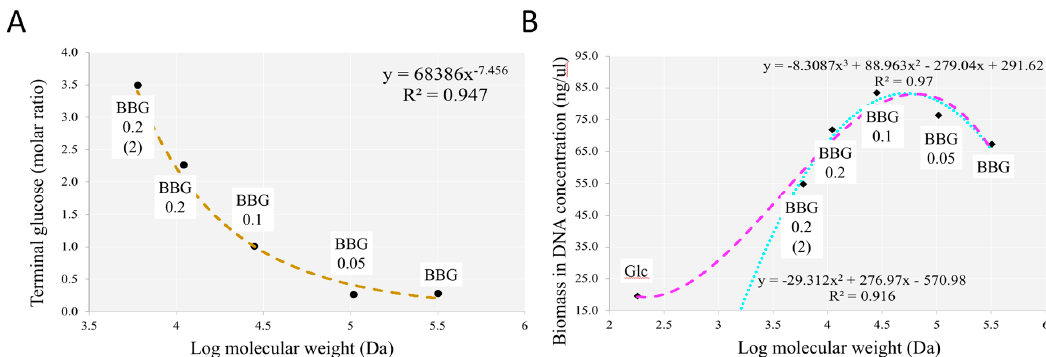
Figure 9. Correlation analysis of selected parameters against BBGs of different MWs with glucose as monomer. ( A ) Terminal glucose molar ratio identified via linkage analysis using GC-MS; ( B )